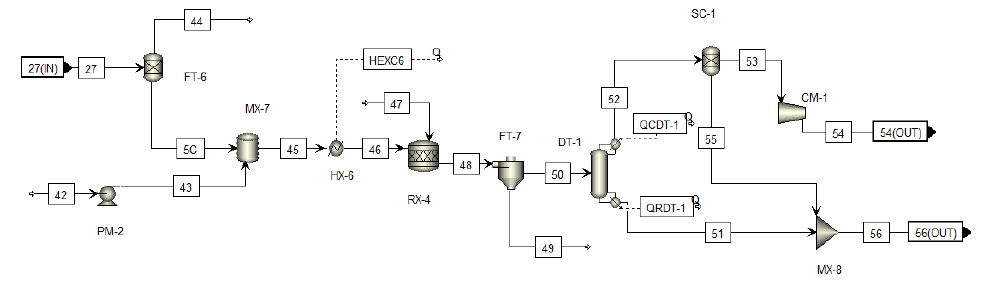
Figure 9. Five-carbon fermentation flowsheet in topology 2.